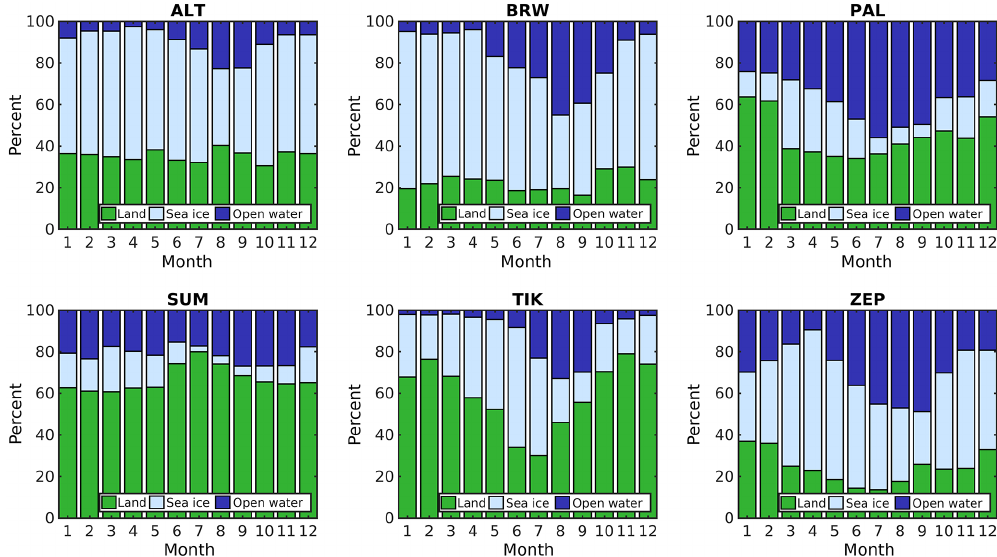
Figure 10. Percent of air mass residence time during the past 7 days spent above different land types before arriving at monitoring station for each month of the year. Green represents land (with no distinction between snow-covered and bare land areas), light blue represents sea ice, and dark blue represents open